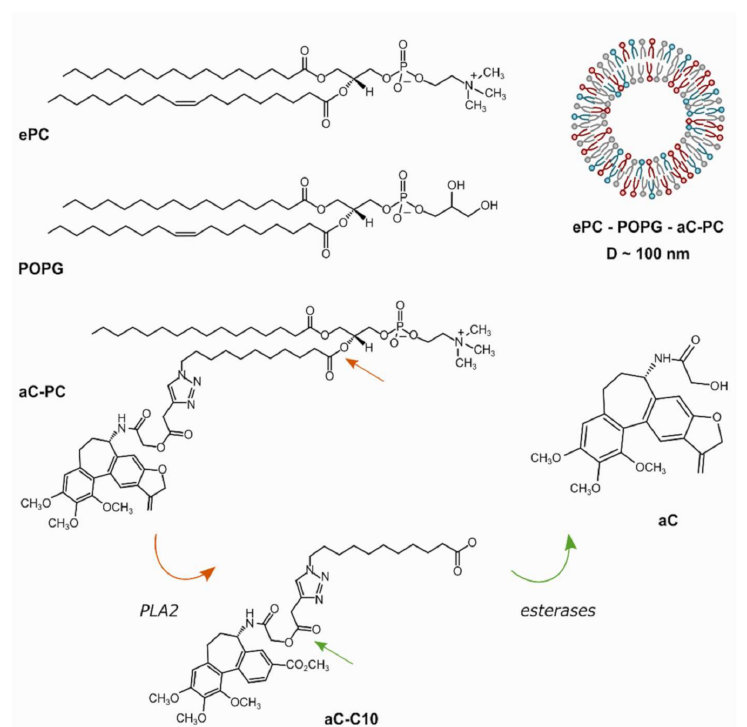
Figure 1. Schematic representation of a liposome with allocolchicinoid phospholipid prodrug ( aC-PC ) in the bilayer and matrix lipids used in the work, egg yolk-derived phosphatidylcholine ( ePC , a representative structure is shown) and 1-palmitoyl-2-oleoylphosphatidylglycerol ( POPG ). The prodrug is subject to enzymatic hydrolysis by phospholipase A2 (PLA2) and non-specific esterases yielding the parent dihydrofuran allocolchicinoid ( aC